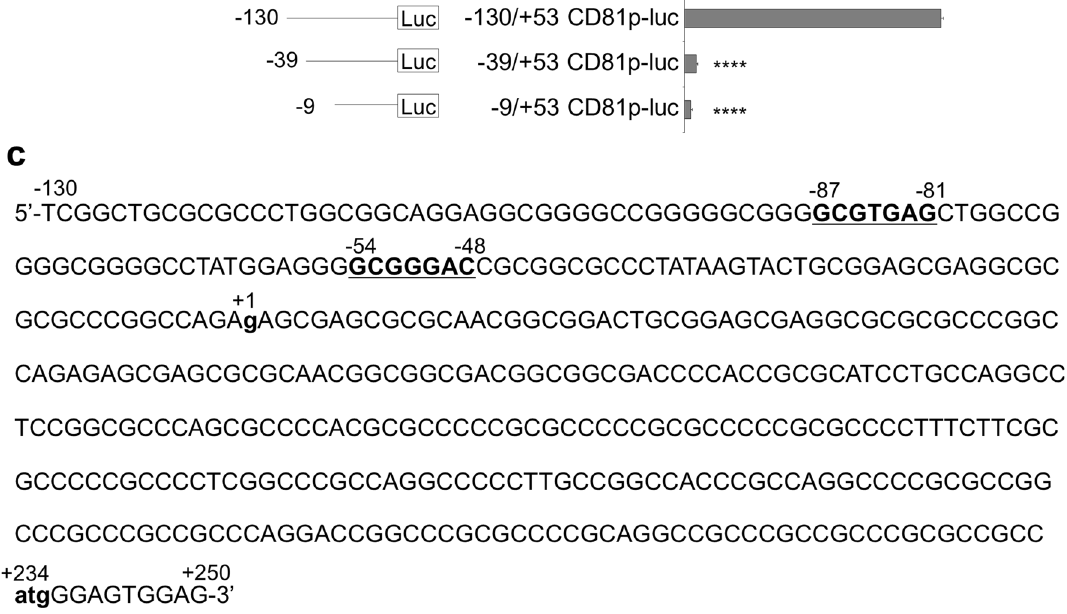
Figure 1. Identification of the proximal promoter region of the CD81 gene. ( a ) Schematic diagrams of luciferase reporter plasmids to evaluate the transcriptional activity of the CD81 gene 5’-flanking region. The DNA fragment between − 1630 bp upstream of CD81 -TSS and + 53 bp downstream of CD81 -TSS was cloned into the promoter-lacking firefly luciferase reporter plasmid (pGL4.11 [ luc2p ]), and the construct was designed as − 1630/ + 53CD81p-luc. Eleven 5’-deleted constructs (− 1480/ + 53, − 1330/ + 53, − 1180/ + 53, − 1030/ + 53, − 730/ + 53, − 580/ + 53, − 430/ + 53, − 280/ + 53, − 130/ + 53, − 39/ + 53, and − 9/ + 53CD81p-luc) were generated from − 1630/ + 53CD81p-luc. The transcriptional start site (TSS) of the CD81 gene is defined as + 1. The luciferase gene is indicated as “ Luc ”. ( b ) Identification of the core promoter region in the CD81 gene. ME180 cells were transiently transfected with the reporter and pSV-β-gal plasmids, and the luciferase activity was measured at 24 h after transfection. Transfection efficiency was normalized by the β-gal activity. The firefly luciferase activity/β-gal activity of − 1630/ + 53CD81p-luc was defined as 1.0. Values are shown as mean ± standard error of three independent experiments. ( c ) The DNA sequence of the 5’ flanking region (from + 250 to − 130 bp) of the CD81 gene. The CD81 -TSS, (+ 1) g , and the translational start codon, (+ 234) atg (+ 236), are shown as bold and lowercase. Two potential Pax5-binding sequences, (-87) GCG TGA G (-81) and (-54) GCG GGA C (-48), are formatted in bold and TSS from − 68 to + 53 bp contains (-54)GCG GGA C(-48) but not (-87)GCG TGA G(-81), meaning that the (-54) GCG GGA C(-48) sequence in CD81 promotor is one of the Pax5-binding sites. Moreover, we tested whether endogenous Pax2, Pax5, and Pax8 bound to the region from − 68 to + 53 bp, which contains the Pax5 core bind- ing site (-54)GCG GGA C(-48) in B-lymphoma cells under physiological conditions (Fig. 3b). The cell extract from Akata cells was subjected to a ChIP assay using anti-Pax2, Pax5, or Pax8 antibody-immobilized beads. Immunoprecipitated endogenous Pax-conjugated DNAs were amplified by PCR using a primer set for detecting the upstream region of CD81 -TSS between − 68 and + 53 bp (− 68/ + 53). The data showed that endogenous Pax5